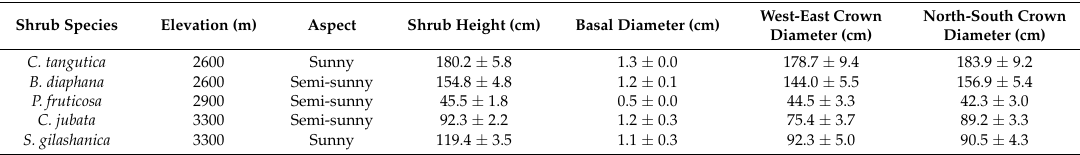
Table 2. Basic parameters of five shrubs